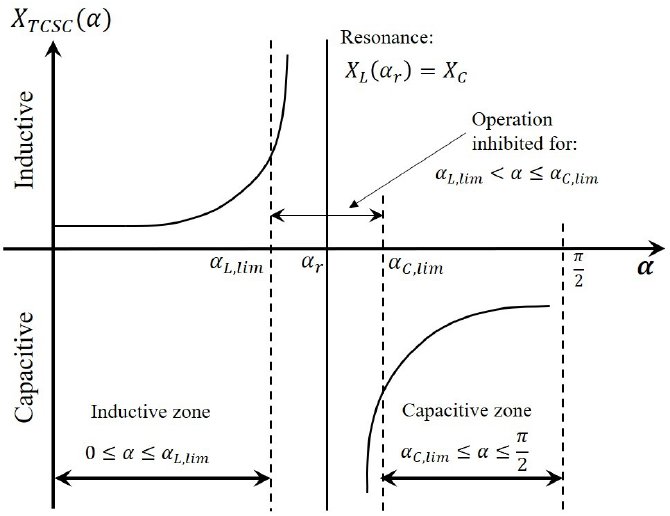
Figure 8. TCSC impedance vs Thyristors firing angle α [4], based on Reference [3].